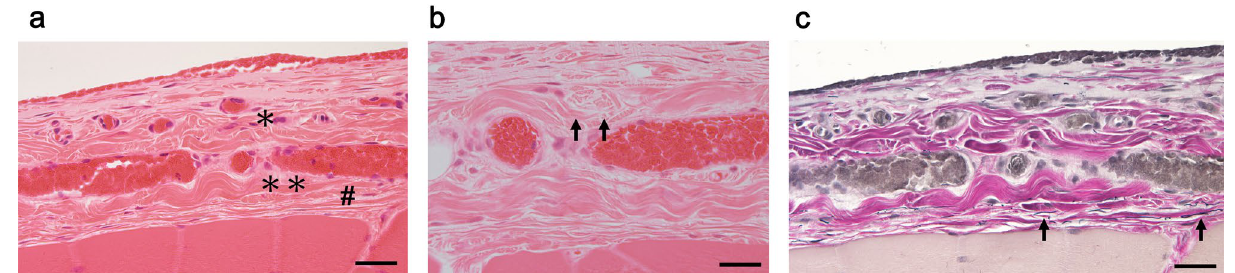
Figure 3. Micrographs of the exposed deep fascia without hook-holding used in plunge freezing followed by freeze-substitution technique. ( a ) Hematoxylin–eosin (HE) stain. The deep fascia has abundant vessels, particularly, the first superficial layer (*) with collagen fibers extending in various directions. The second intermediate layer was formed by strongly wavy and thick bundles of collagen fibers (**). The third, deepest layer displayed straight and thin bundles of collagen fibers (#). Scale bar = 20 µm. ( b ) HE stain. The nerve tissue was identified (arrow) in the first superficial layer. Scale bar = 15 µm. ( c ) Elastica Van Gieson (EVG) stain. Collagen bands were forming clearly different layers. Elastic fibers (arrow) were identified in all layers of the deep fascia. Scale bar = 20